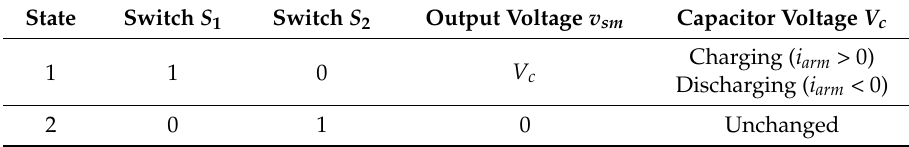
Table 1. The charging and discharging characteristics of the half-bridge submodule.